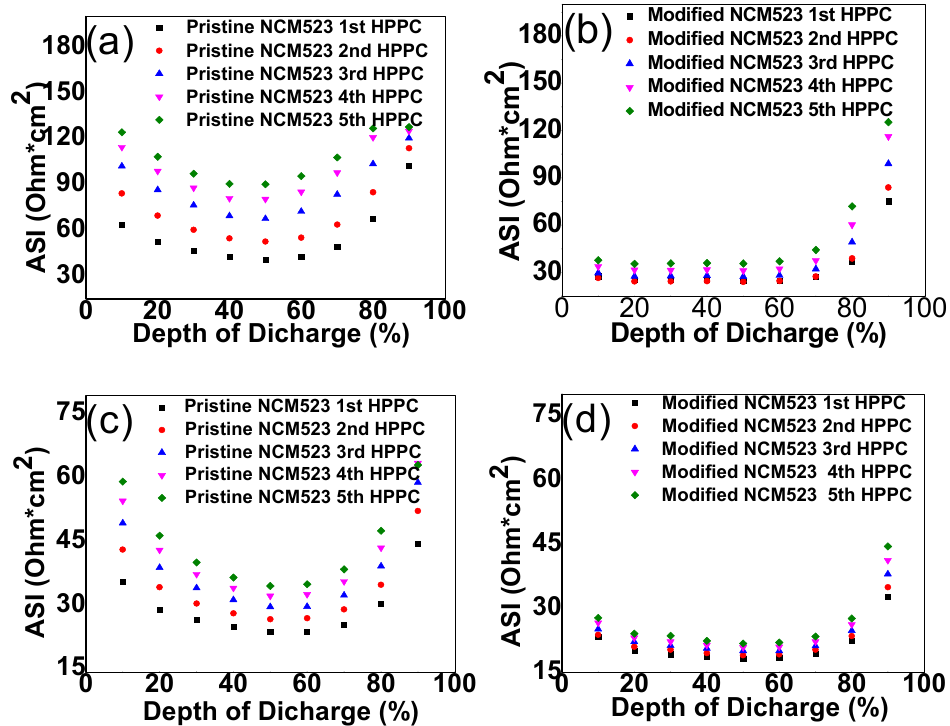
Figure 6. ASI of pristine NCM523 and NCM523 with Al 2 O 3 coating doping in ( a , b ) half-cells and ( c , d ) full cells.